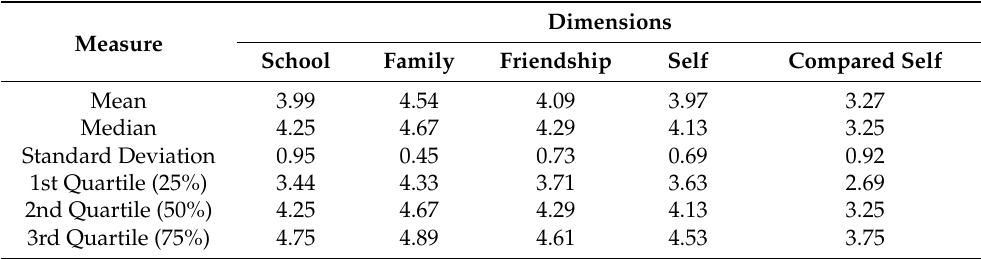
Table 3. Dimensions of the MSSLC, in the context of the COVID-19 pandemic, of students from